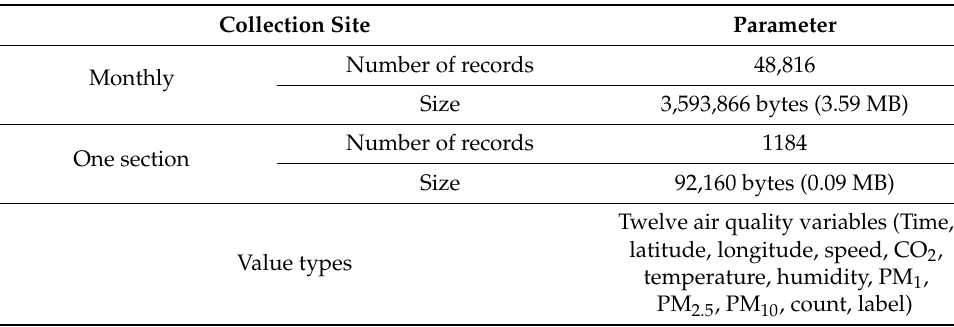
Figure 6. The raw section sensor data plotted for each parameter. 5. Data Processing for Time Series Data This section will briefly introduce the flow of preparing the real-time data, labelling the data, and performing the data normalization procedure. This study uses time-series data, which is an ordered sequence data. The time interval between the data point is con- tinuous and each time unit observation has at most, one data point. The real-time sensor data might have data errors such as sensor error and outlier data prone to a false trend. The data preprocessing method is introduced to reduce the training complexity and to increase the accuracy while feeding the data into the prediction algo- rithms. The next step of the data preparation is labelling the sensor data. After completing the labelling process, the data will be run through a series of ML experiments to figure out the most compatible ML parameters for the air quality system. There are a total of six input data used for the ML, which are CO 2 , PM 2.5 , PM 10 , vehicle speed, temperature, and humidity.